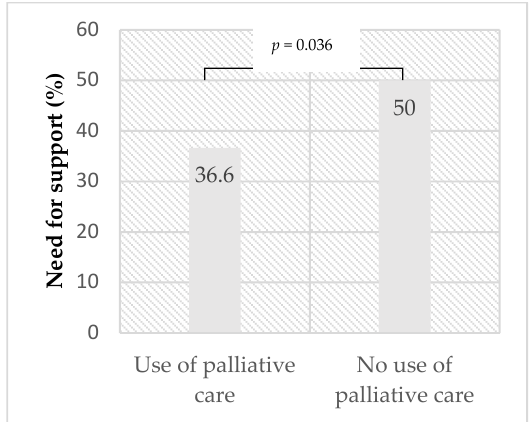
Figure A2. Sufficient case conference and the use of palliative care: confidence in doctors’ decisions with and without the use of palliative care, with data in percentage (%), Mann – Whitney U test, p < 0.05.